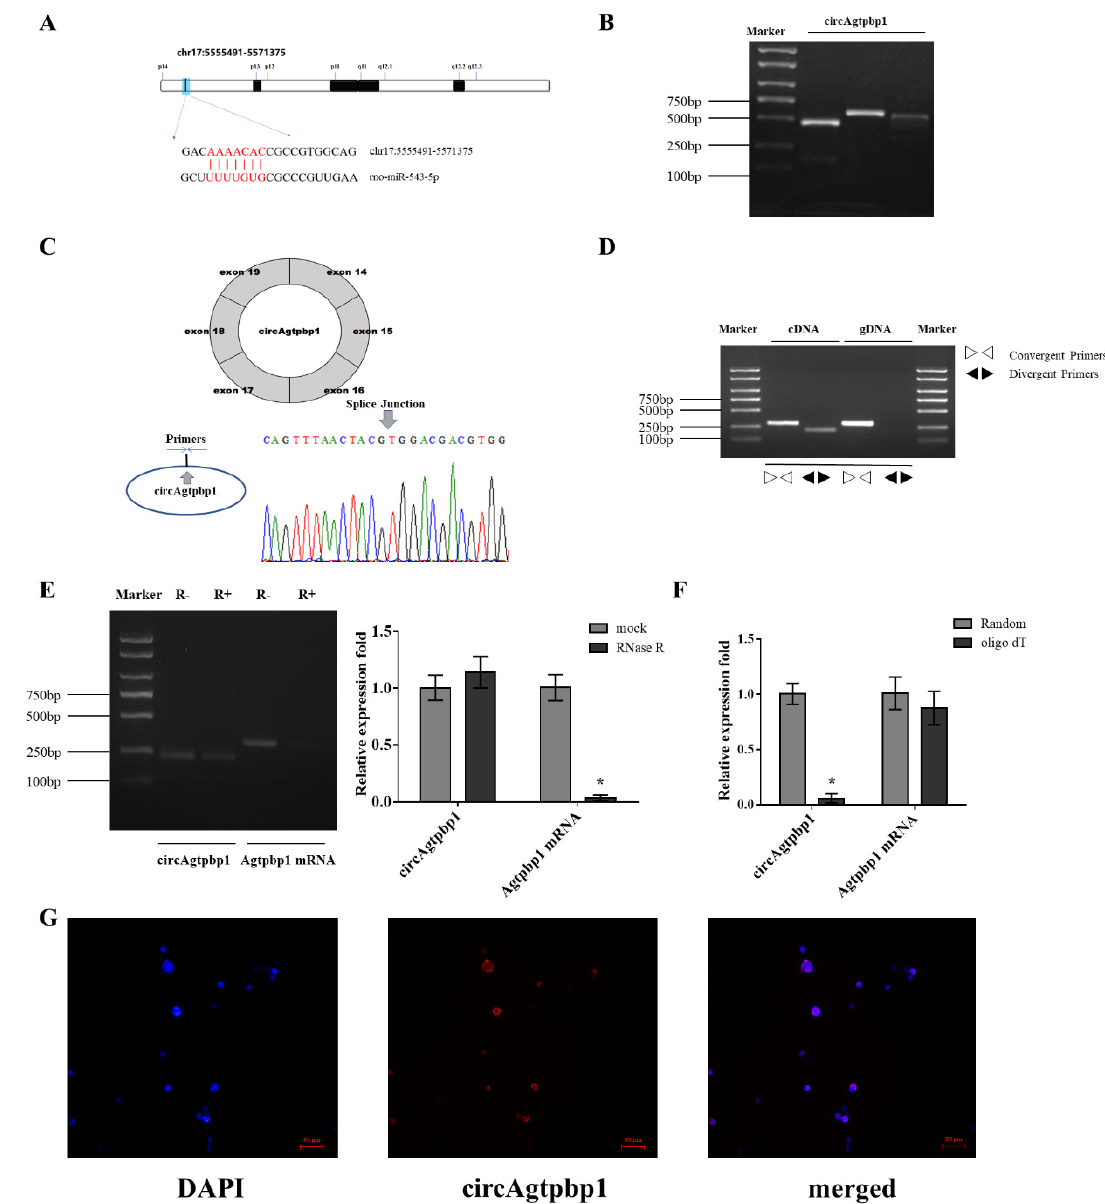
Figure 1. Identification and validation of circular RNAs (circRNA). ( A ) Schematic illustration demonstrates the binding sites of miR-543-5p in rno_circ_0001059. CircAgtpbp1 is produced by the Agtpbp1 gene of exons in chromosome 17. ( B ) The presence of rno_circ_0001059 was validated by PCR followed by agarose gel electrophoresis and Sanger sequencing. ( C ) Arrows represent divergent primers binding to the genomic region of circAgtpbp1. ( D ) RT–PCR assay with divergent or convergent primers indicated the existence of circAgtpbp1 in rat pituitary cells. GAPDH was used as a negative control. ( E ) RT–qPCR analysis of circAgtpbp1 and Agtpbp1 mRNA the relative expression level after treatment with RNase R. ( F ) The relative circAgtpbp1 and Agtpbp1 mRNA levels were analyzed by RT–qPCR after the reverse transcription with Random were labeled with Cy3. Nuclei were stained with DAPI. At least three replicates of each experiment were performed. Mean values and standard deviations (SD) of data are shown. One-way ANOVA was applied to determine statistical significance. p < 0.05 was considered significant. *, p <